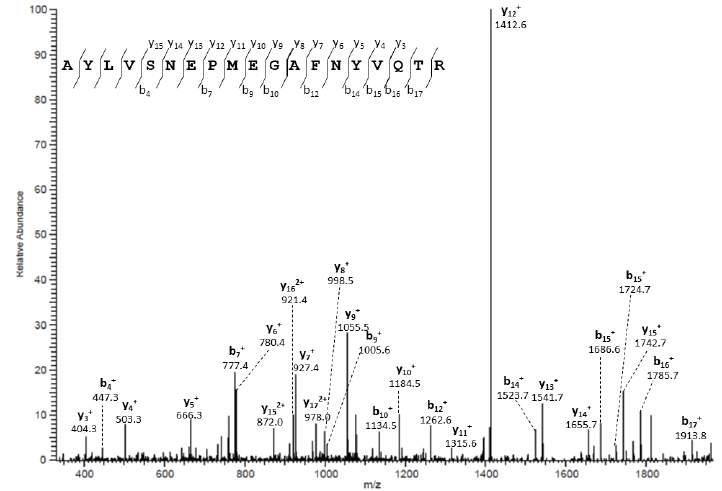
Figure 4. PIP interacts with AQP5 in mouse SGs. Tandem mass spectra of PIP peptides obtained following AQP5 immunoprecipitation in mouse SGs.